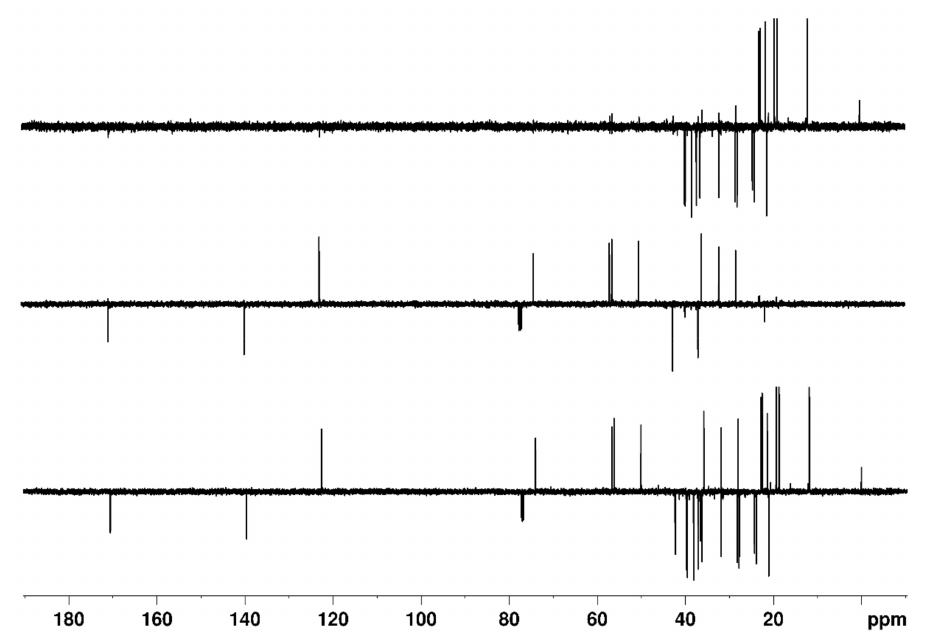
Figure 5. Bottom : DEPTQ + 45 90 ; middle : DEPTQ + 90 45 ; top : Difference between DEPTQ + 45 90 and DEPTQ + 90 45 spectra of 30 mg of cholesteryl acetate dissolved in 0.7 mL CDCl 3 . The delays δ 1 , δ 2 , and δ 3 were set to 3.13 ms, adjusted for a coupling constant 1 J CH of 160 Hz, to 4.35 ms, adjusted for a coupling constant 1 J CH of 115 Hz, and to 3.45 ms, adjusted for a coupling constant 1 J CH of 145 Hz,